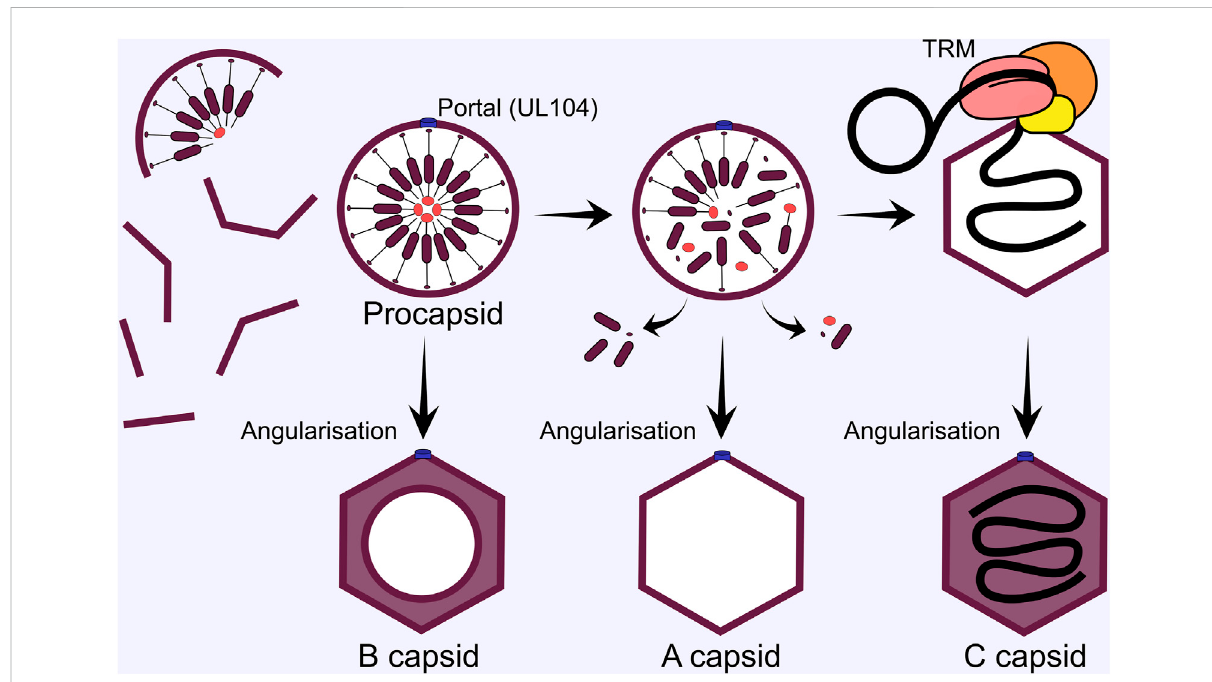
FIGURE 7 HCMV capsid subunits self-assemble around the scaffold in the nucleus. Once the spherical procapsid is fully assembled, divergence in capsid maturation pathwayscan occur.If theprocapsidangularises to theicosahedral form before thescaffold is removed aB capsid is formed that cannot undergo subsequent maturation. Next, the protease cleaves the scaffold to release it from the interior of the procapsid, and it is ejected through enlarged hexon pores. Ifangularisation occurs after thisstep, but before terminase complex engagement, an empty A capsidis formed. Mature Ccapsidsareformedwhentheterminase complexsuccessfully engagesthecapsidanddeliversagenome.The terminase complex provides energy for genome translocation through ATP hydrolysis, and cleaves unit length genomes from the newly replicated concatemers by endonuclease activity. TRM, tripartite terminase